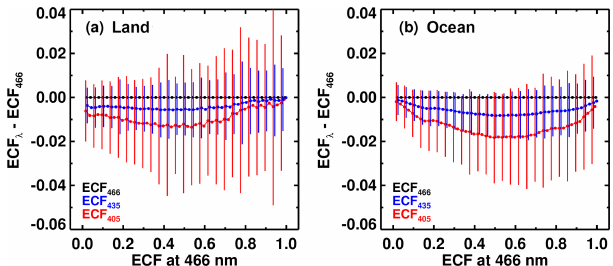
Figure 16. Differences between ECFs retrieved at 405 and 435nm and ECF retrieved at 466nm as a function of ECF at 466nm for 13 November 2006. (a) Land; (b)